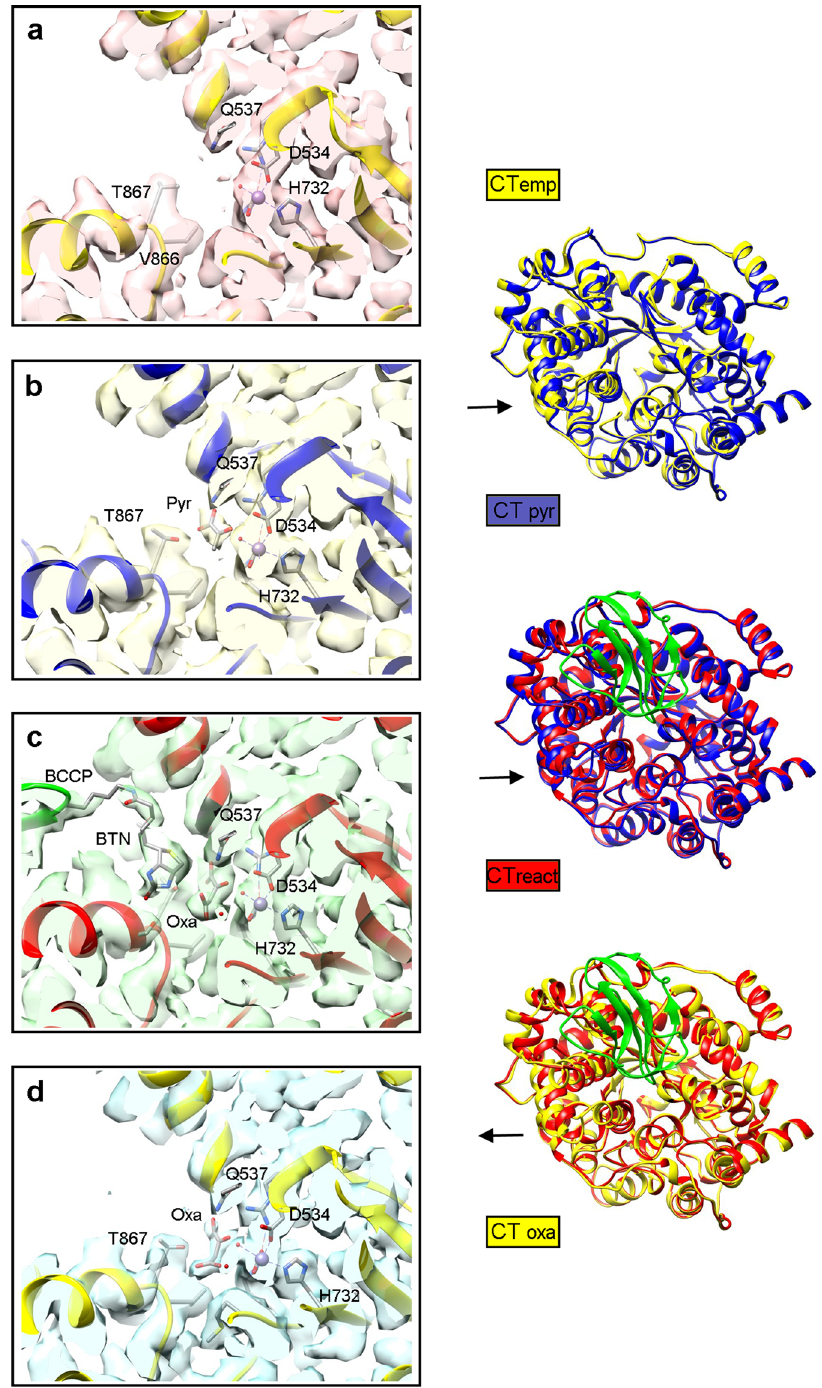
Fig.5|CatalyticstatesattheCTactivesite. CryoEMmapstogetherwithmodeled atomiccoordinatesareshownfocusedontheactivesiteoftheCTdomain.Thefour states displayed correspondto: a anempty activesite (CT empty ); b pyruvate bound (CT pyr ); c biotin inside the active site and density for oxaloacetate (CT react ); d oxaloacetate at the active site (CT oxa ). On the right panels the pairs of the